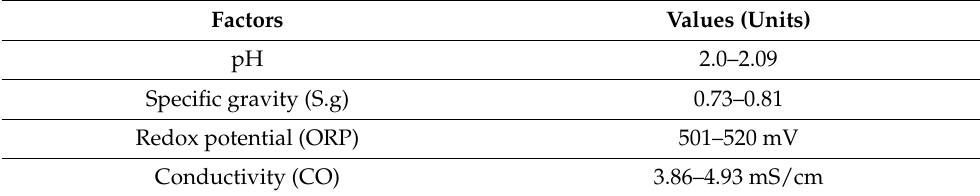
Table 1. Physico-chemical properties of N. mirabilis pitcher fluid juice before fractionation.